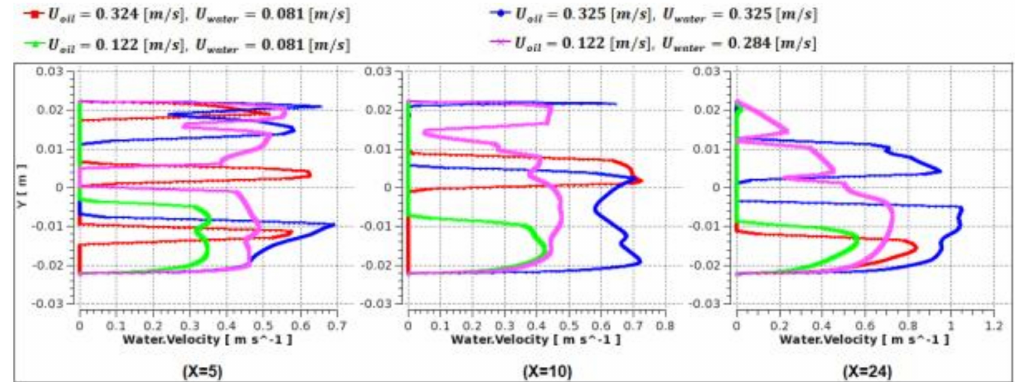
Figure 9. Variation of the water velocity along the vertical line in the Y direction at z = 0 and various dimensionless distances of x = L / D.